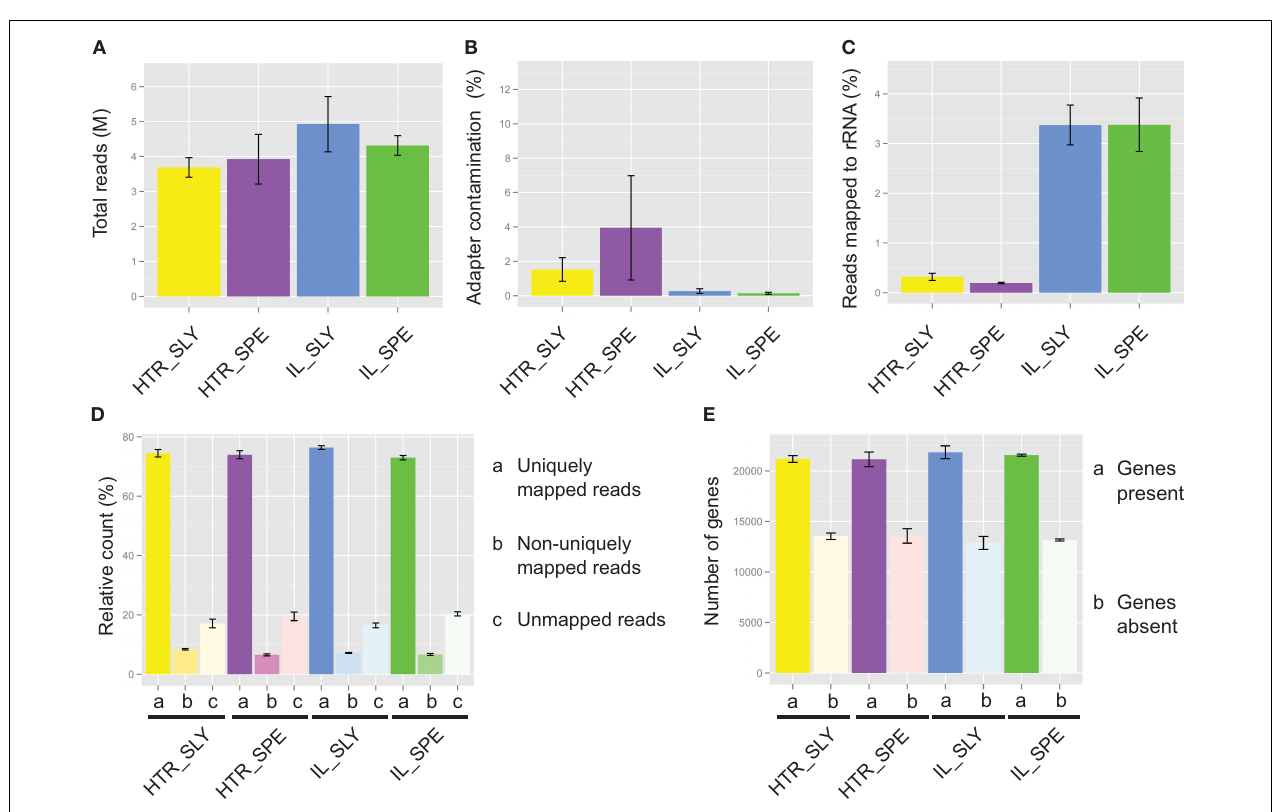
Number of detected genes.The read mapping data from IL and HTR protocols using S. lycopersicum (SLY) and S. pennellii (SPE) are shown. Graphs were made in R using ggplot2. Error bars are ±